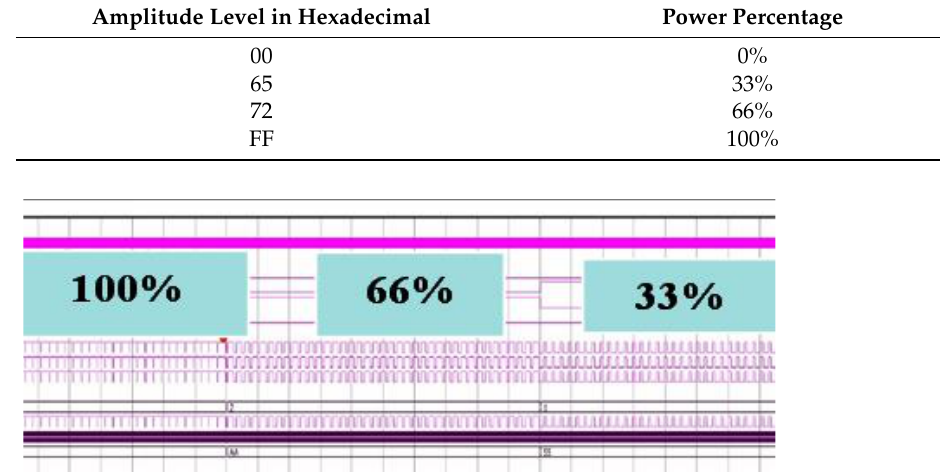
Figure 10. ModelSim Simulation Waveform.